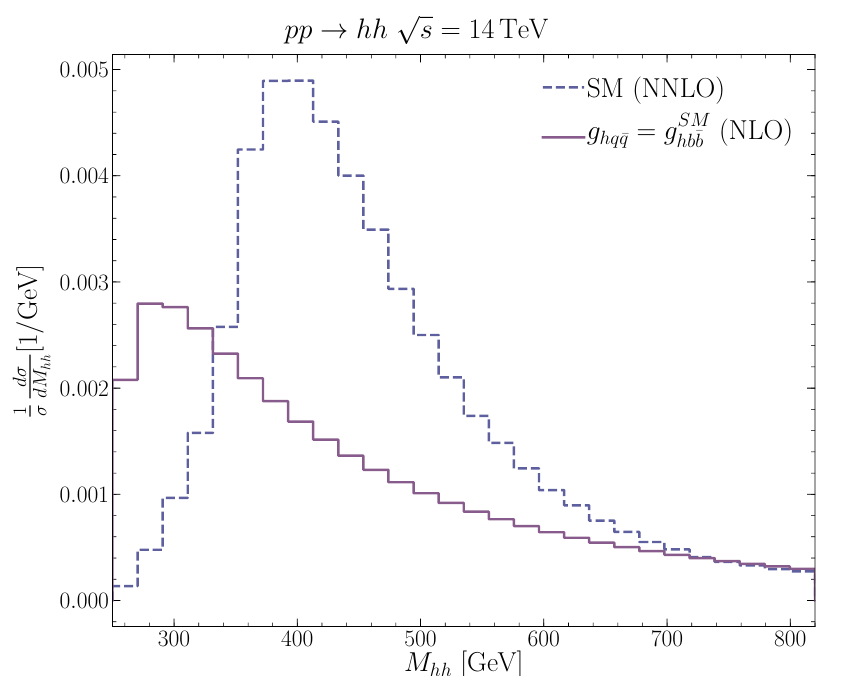
Figure 8 . The qqA normalised NLO invariant mass di(cid:11)erential cross section distribution for the benchmark point ( g hqq = g SM ) (solid line) and the NNLO SM ggF cross section obtained from [70] hbb (dashed